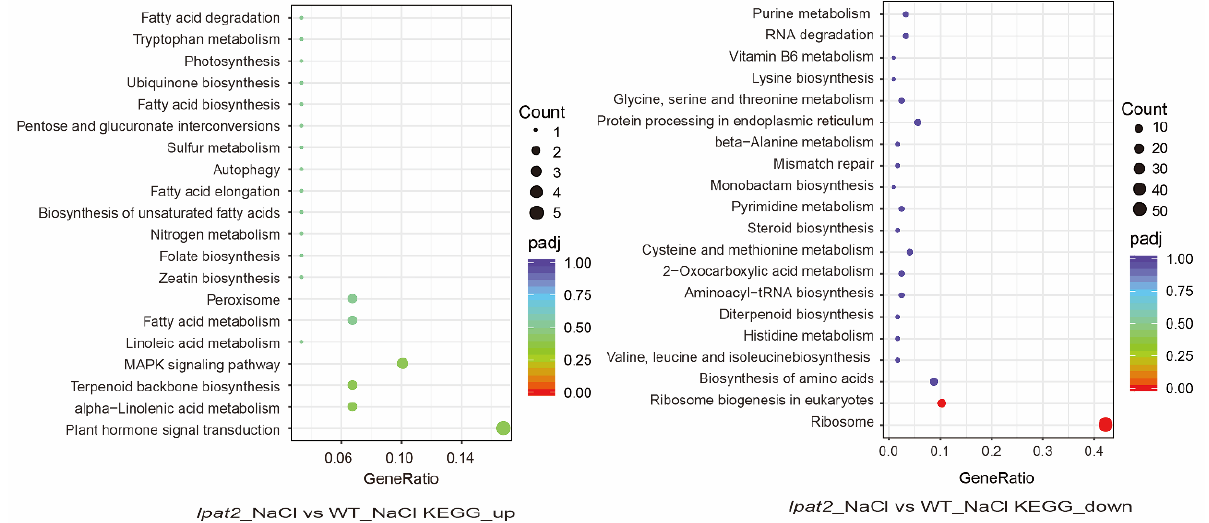
Figure 8. Differentially expressed genes (DEGs) in various pathways by KEGG analysis. Differentially expressed genes (DEGs) in lpat2 mutant versus (vs) WT under salt stress conditions. The circle size shows the number of DEGs, the color of the circle means p value adjustion (padj), and the horizontal axis means the proportion of DEGs in the total number of